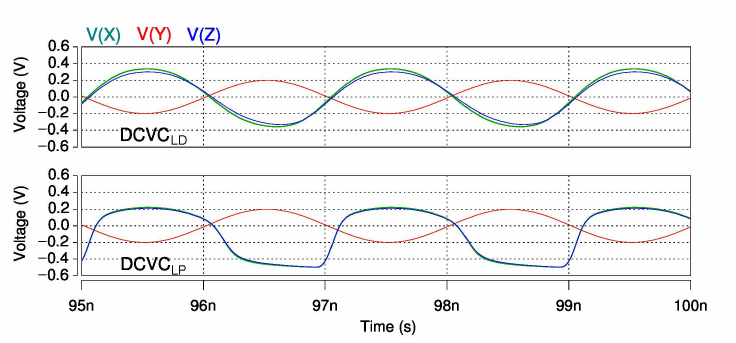
Figure 7. Inputs and outputs waveforms for DCVC LD and DCVC LP